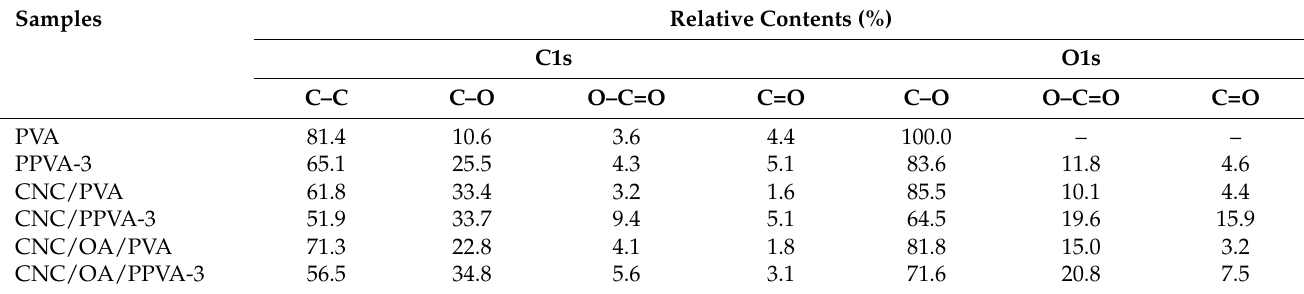
Figure 4. High resolution XPS spectra of C1s of different films without and with air plasma treatment. Table 2. Relative contents of different chemical bonding relationships in XPS-C1s and -O1s